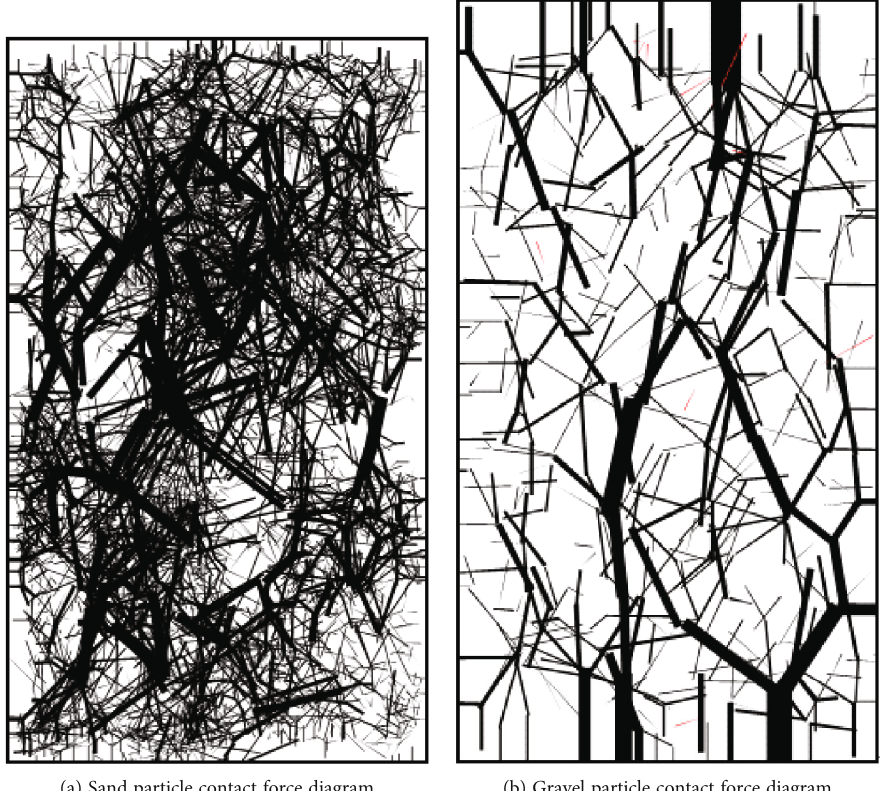
Figure 13: Particle contact force